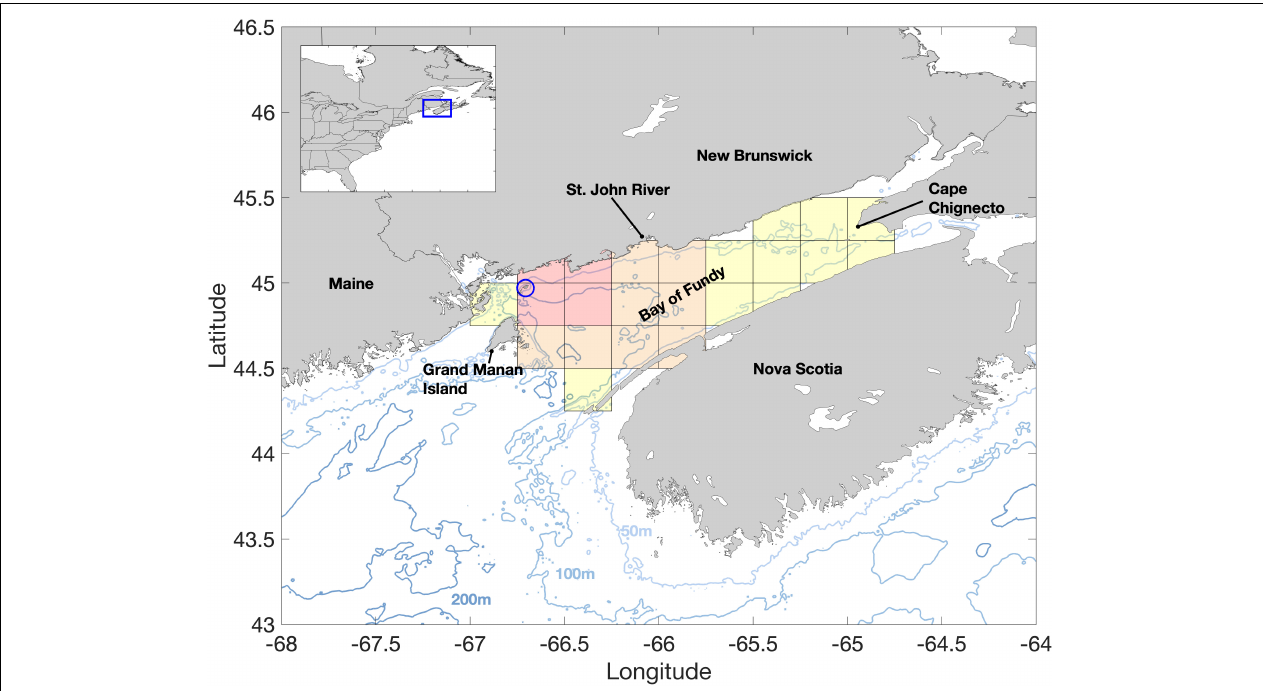
FIGURE 1 | The study area showing major geographic locations and bathymetry (m). The sampling site for Alexandrium catenella cell counts in the Bay of Fundy at Wolves Islands is denoted by the blue circle. The OISST domain is denoted by the gridded area with shades representing the different areas used in our analysis. The four red grid points near Wolves Islands in the OISST data define the thermal habitats for A. catenella . The area we term the central basin of the Bay of Fundy, and used to calculate the onset dates of the thermal habitats, is represented by the orange and red grid points. Finally, OISST data used for climate and long-term trends analysis are derived from all grid points (red, orange and yellow shades) and extend from Grand Manan Island (United States) to Cape Chignecto (Canada). Wind data was averaged over the entire Bay of